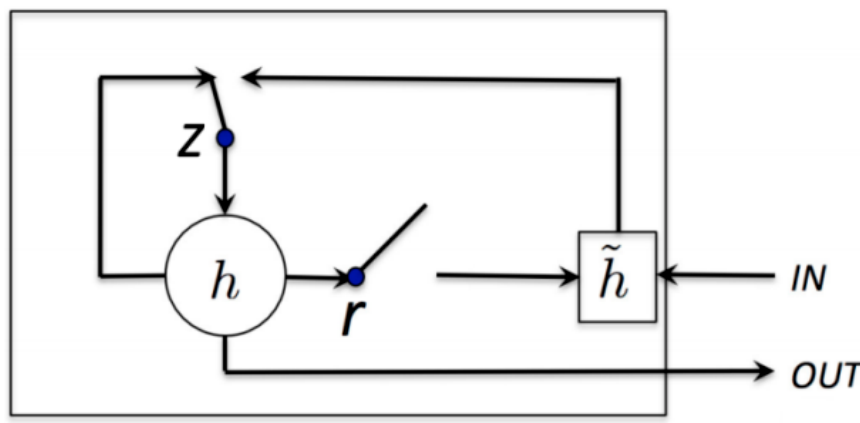
Figure 6. The architecture of a GRU recurrent neural network [51].